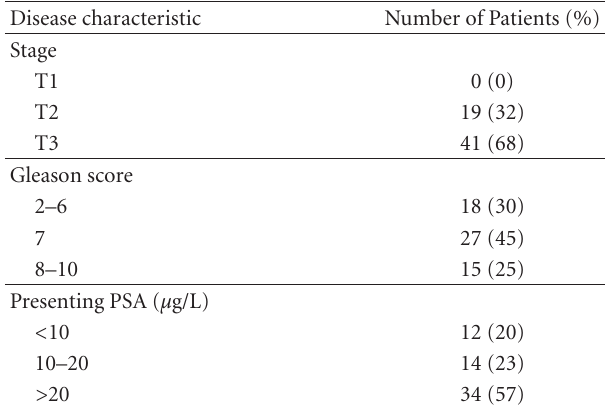
Table 1: Baseline patient